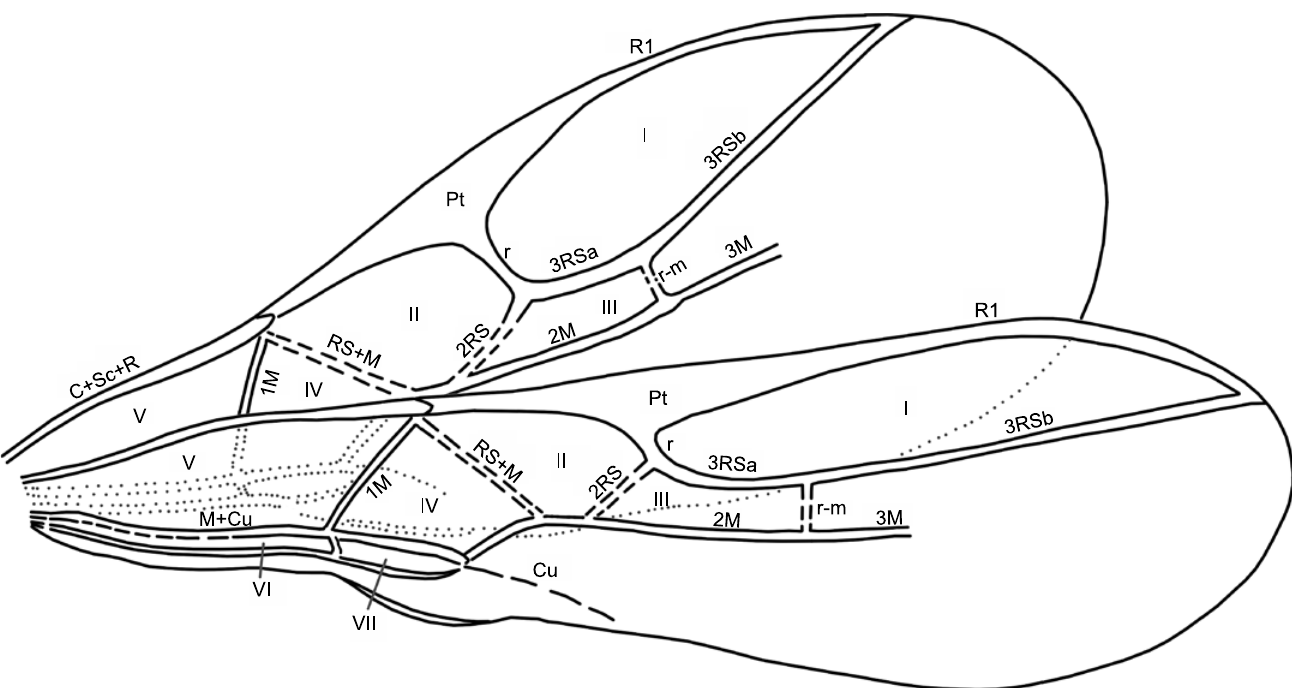
Fig. 2. Schema of forewing venation of aphidiine wasp Ephedrus rasnitsyni Davidian and Kaliuzhna sp. nov., holotype PIN 3387/79, Starodubskoye, Sakhalinian amber (Russia), middle Eocene. Abbreviations: Veins: C+Sc+R, costa+subcosta+radius; Pt, pterostigma; R1, metacarp, anterior branch of ra- dius; r, cross vein connecting pterostigma and radial sector; Pt, pterostigma; RS, radial sector; 3RSa, 3RSb, a and b sections of 3rd abscissa of radial sector; 1M, 2M, 3M, 1st, 2nd and 3rd abscissae of media; RS+M, radial sector+media; 2RS, 2nd abscissa of radial sector; r-m, cross vein connecting radius and media; M+Cu, media+cubitus; Cu, cubitus. Cells: I, marginal; II, 1st submarginal; III, 2nd submarginal; IV, 1st discal; V, basal; VI, subbasal; VII,